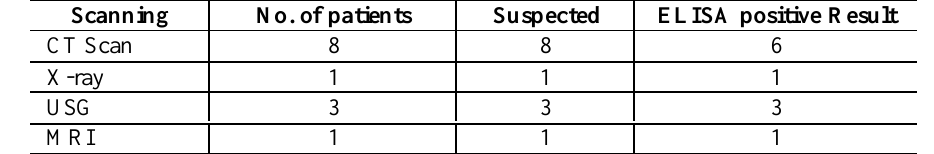
Table III : Comparison of various scanning with ELISA Scanning